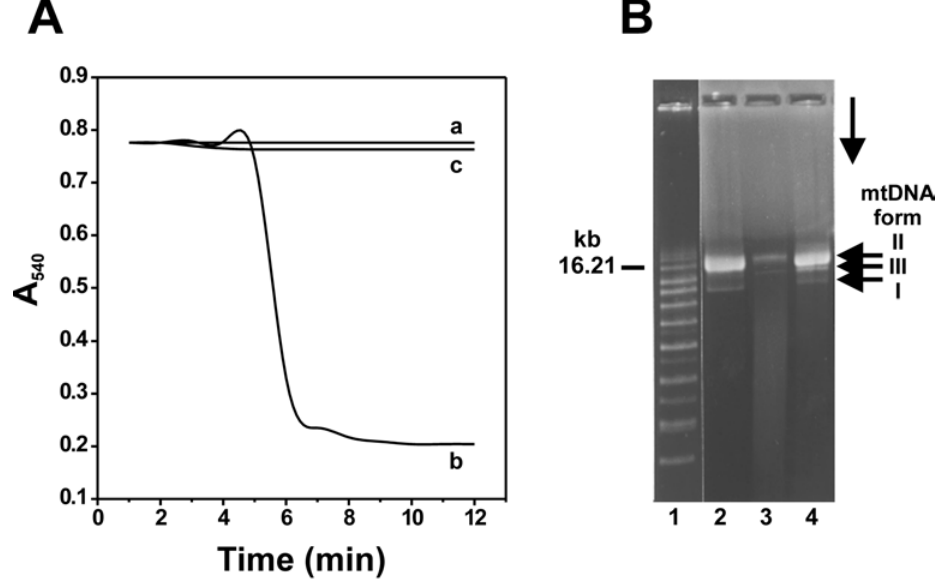
Fig. 2 – Effect of Fe 2+ -citrate on mitochondrial swelling ( A ) and mtDNA damage ( B ). Panel A : RLM (1 mg/ml) were incubated in the standard medium containing 1 mM EGTA (trace a), 50 µ M Fe 2+ and 2 mM citrate (trace b), and 50 µ M Fe 2+ , 2 mM citrate, and 20 µ M BHT (trace c). Panel B : Agarose gel electrophoresis analysis of mtDNA obtained from Fe 2+ -citrate-treated mitochondria. mtDNA extracted from 80 mg of RLM incubated at 1 mg/ml protein concentration in the presence of 1 mM EGTA (lane 1), 50 µ M Fe 2+ and 2 mM citrate (lane 2), and 50 µ M Fe 2+ , 2 mM citrate, and 20 µ M BHT (lane 3), at 25 ◦ C for 15 min. mtDNA archetypal conformations: supercoiled (form I), open relaxed (form II), and linear (form